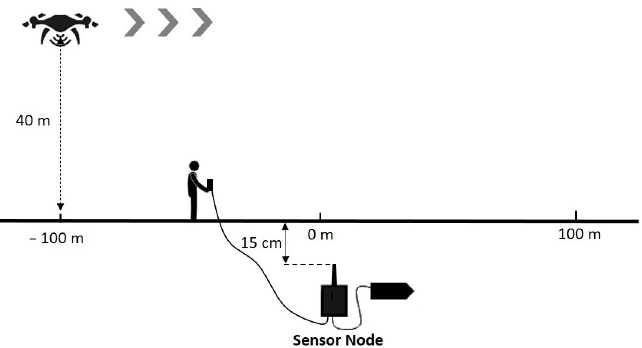
Figure 10. Experimental setup in dynamic mode to study the UG2AIR communication link at different speeds. The UAV flies at the altitude of 40 m. At each reception of a data frame, the collector node measures the level of the RSSI